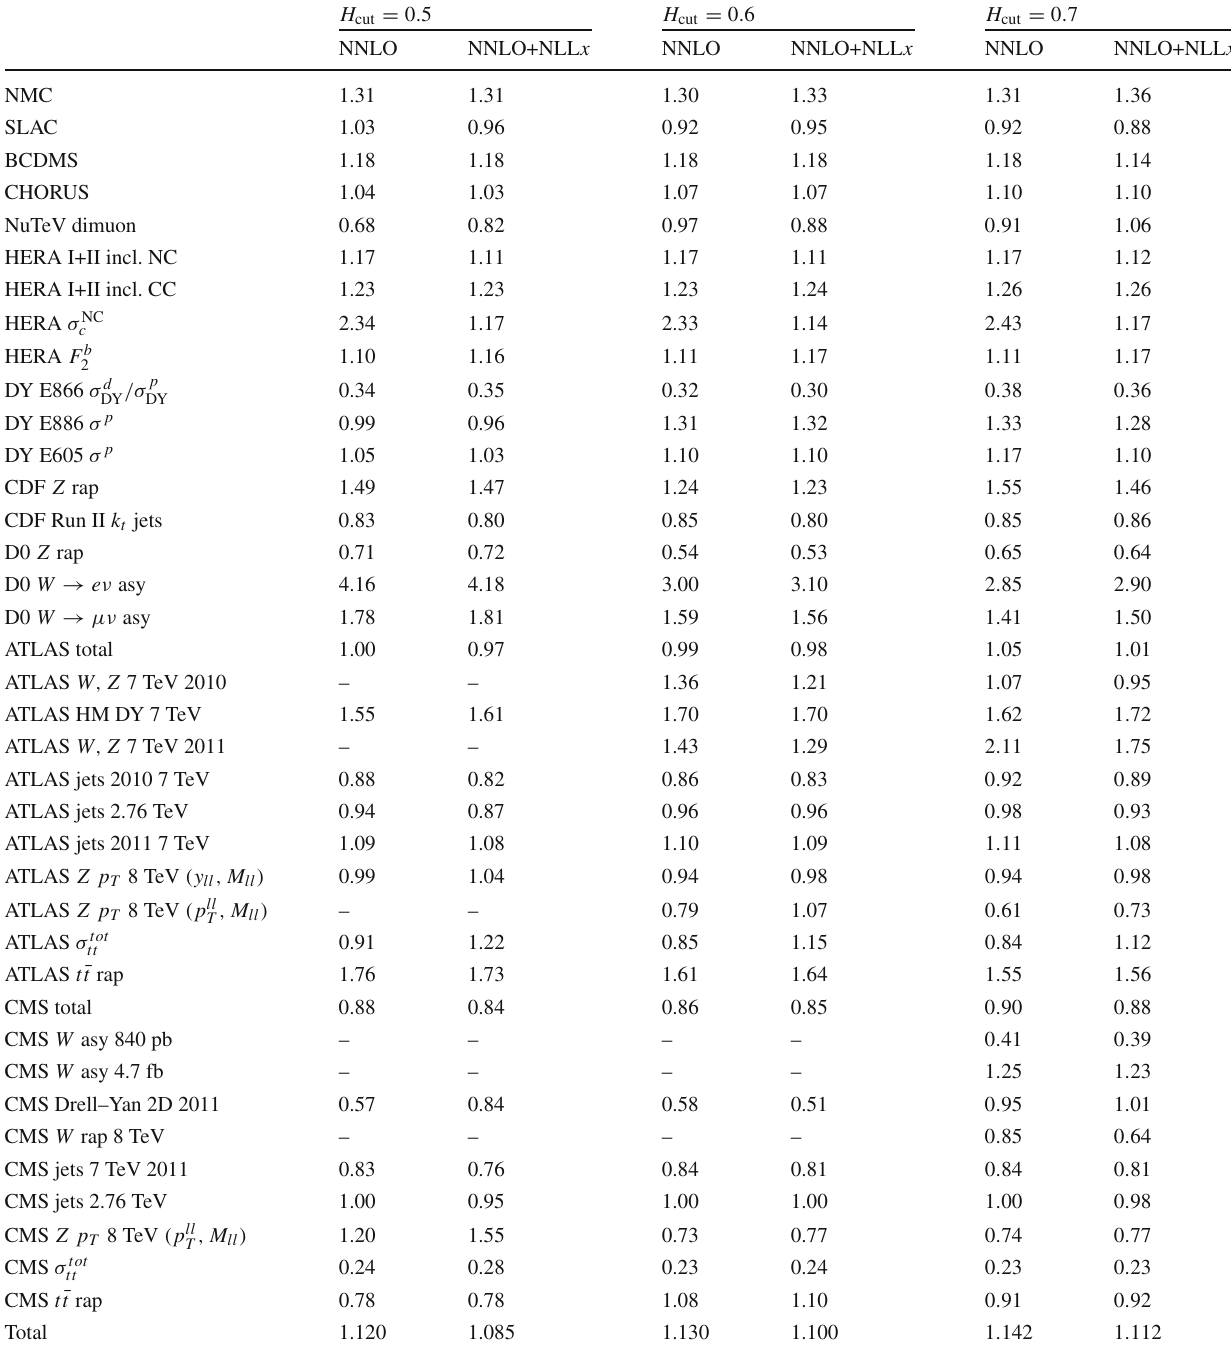
Table 5 Same as Table 4, now comparing the values of the χ 2 / N dat for the global NNLO and NNLO+NLL x fits obtained with different values of the hadronic data cut, H cut = 0 . 5 , 0 . 6 and 0.7. Note that fits with different values of H cut have in general a different number of